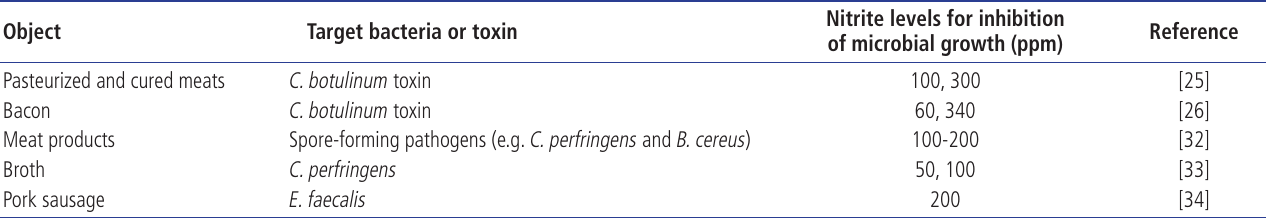
Table 1. Various nitrite levels to control microbial growth